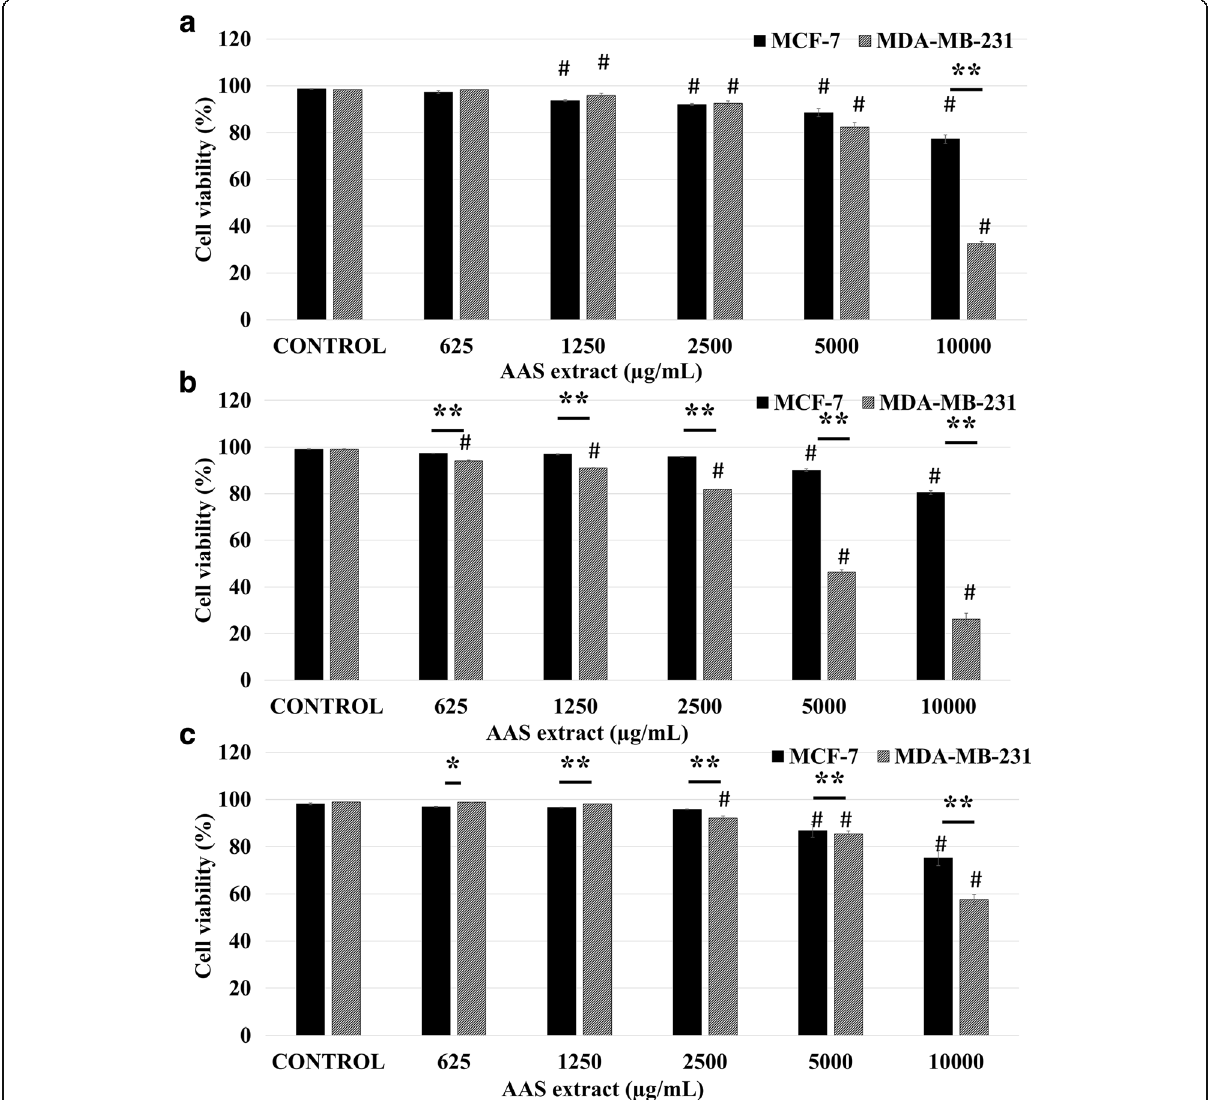
Fig. 4 AAS extract significantly reduces viability of MCF-7 and MDA-MB-231cells. The % viability of breast cancer cells was determined by viability assay for 24 h ( a ), 48 h ( b ) and 72 h ( c ). Data represents mean ± S.E.M. of six independent experiments. Statistical significance: #, p < 0.05 vs control according to ANOVA followed by Newman-Keuls post hoc analysis.*, p < 0.05 and **, p < 0.01 MCF-7 vs MDA-MB-231 according to Student ’ s t-